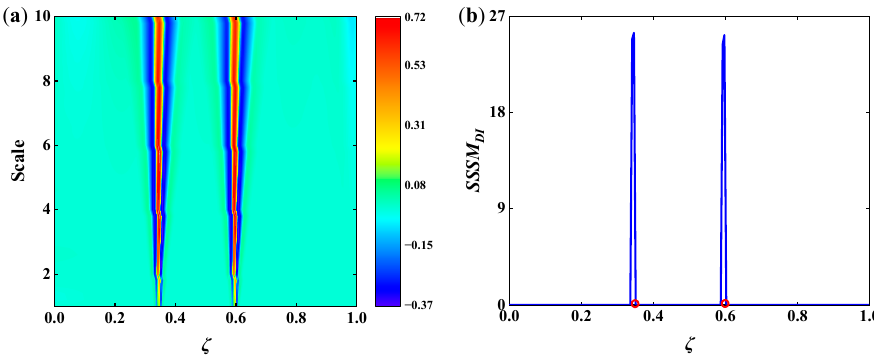
Figure 15. Damage identification results under scenario II: ( a ) CS ( b, s ) ; ( b ) Damage index SSSM DI .